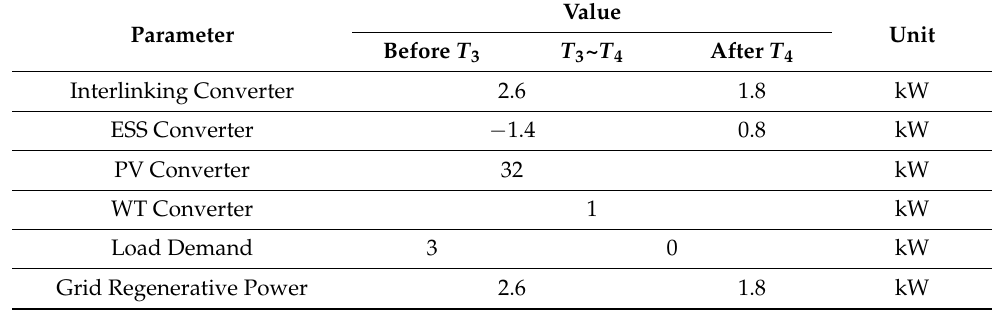
Table 9. Power flow of each power converter in operation mode 6. Parameter